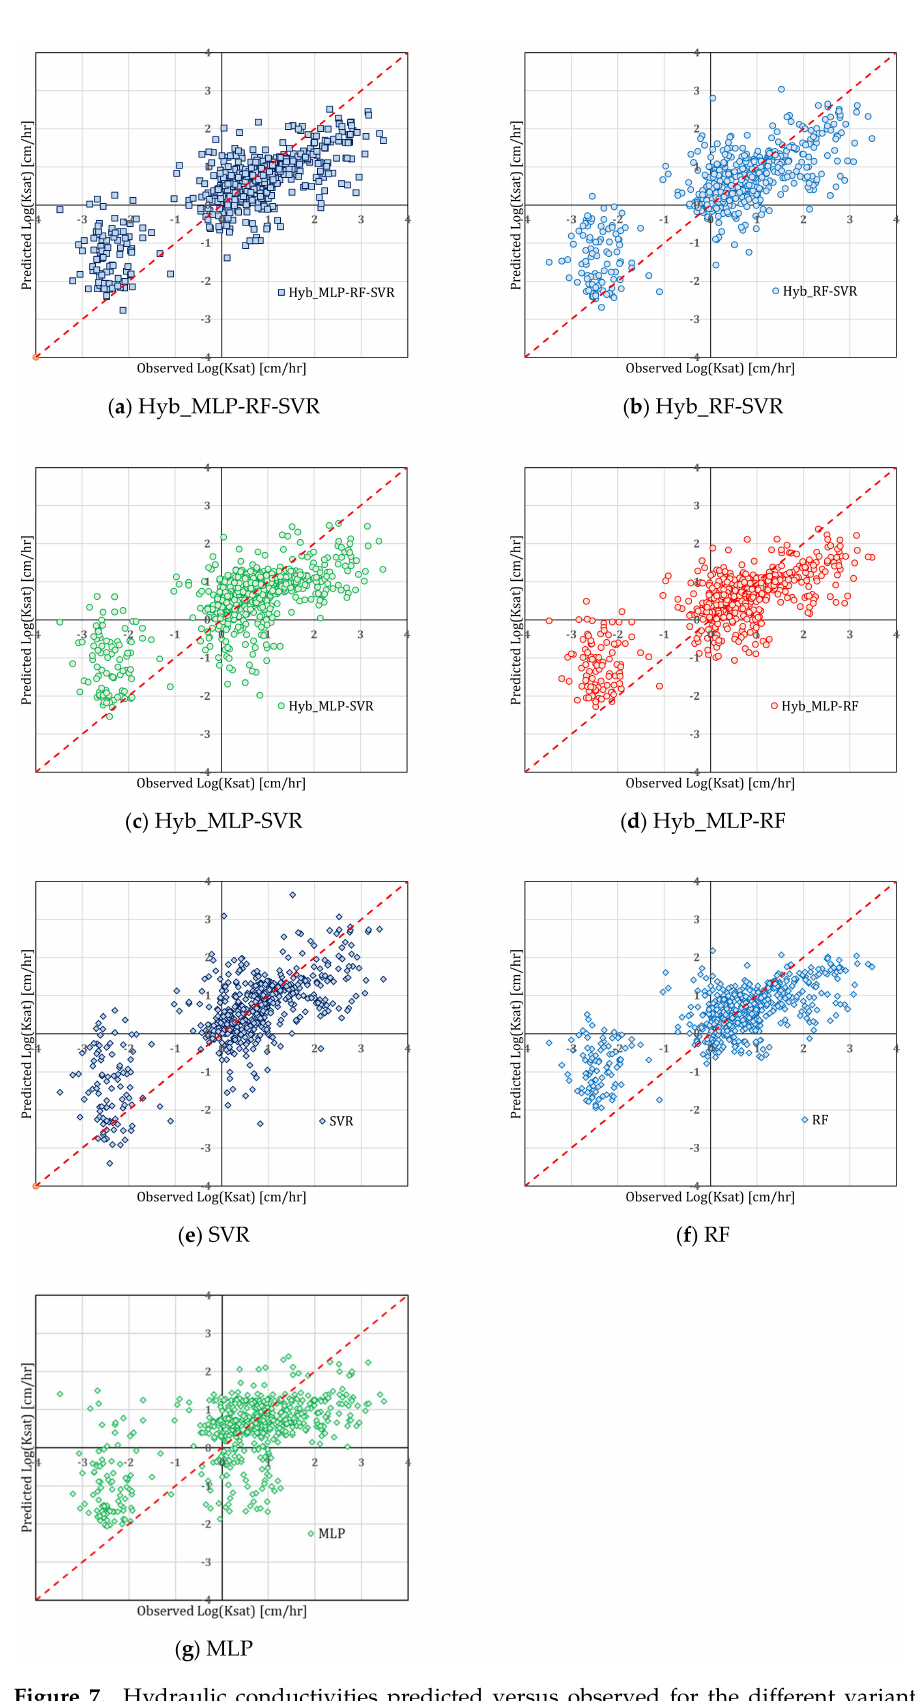
Figure 7. Hydraulic conductivities predicted versus observed for the different variants of the M1